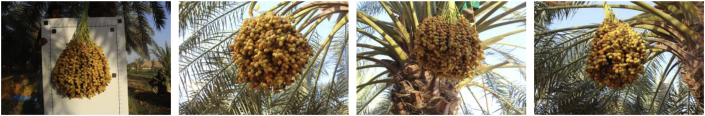
Sample images of one date bunch captured in ideal front view (with uniform background) and from other angles on the palm.